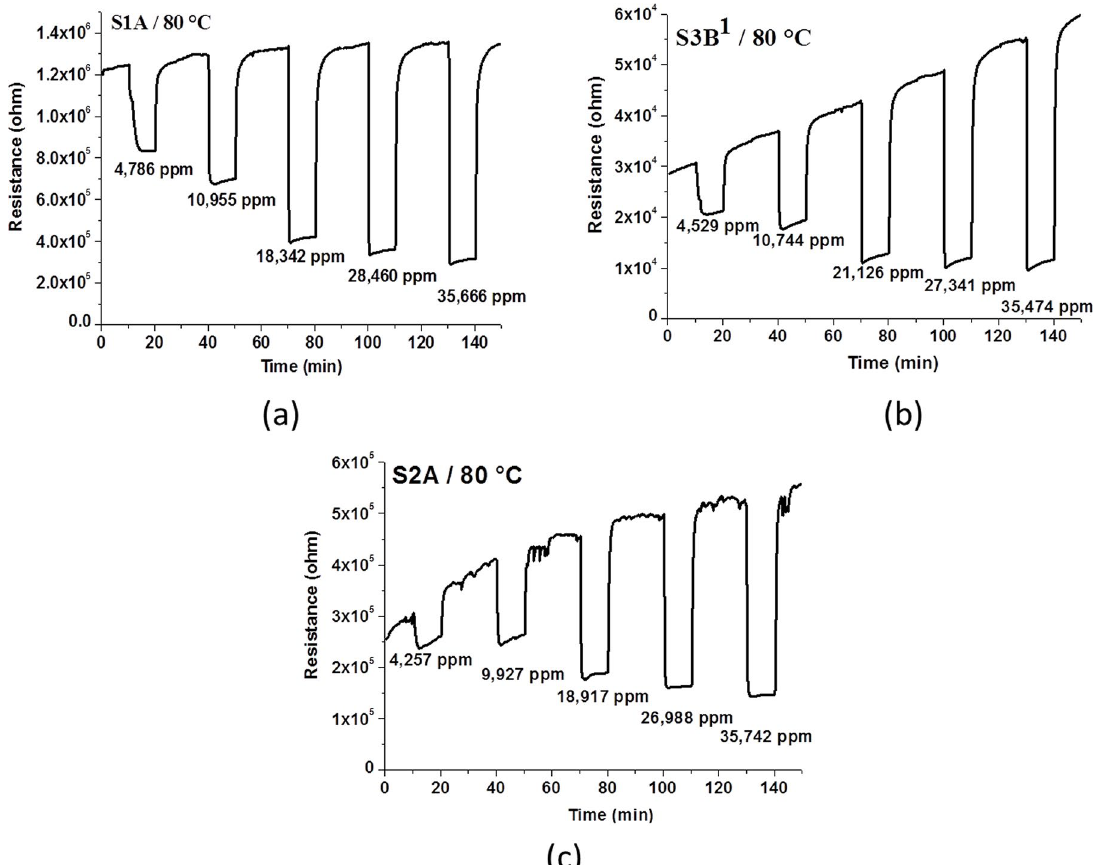
nanoparticle sensors at different CH 2